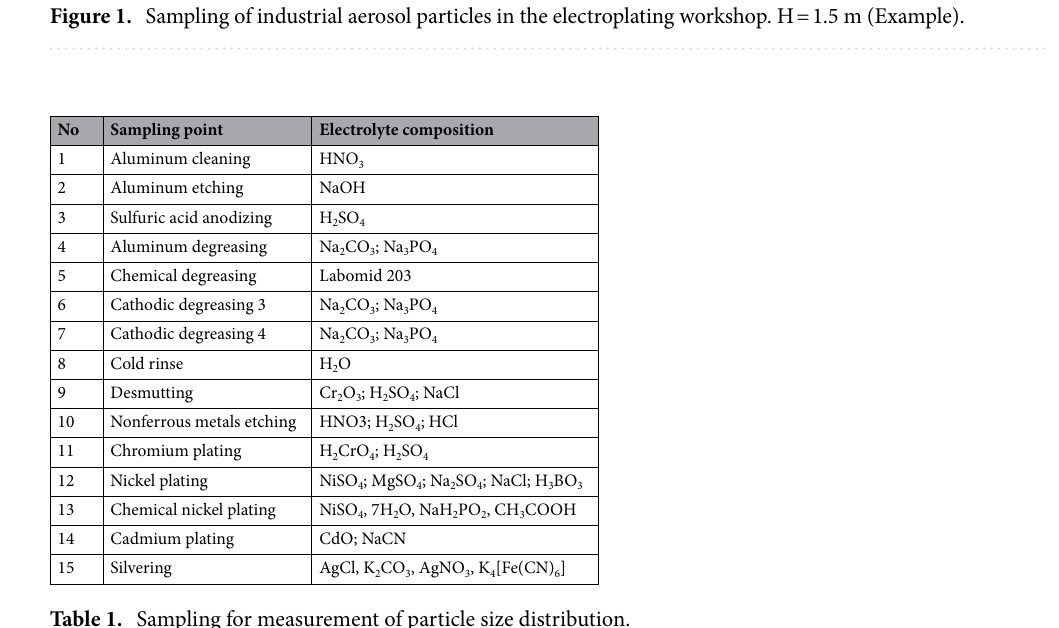
Table 1. Sampling for measurement of particle size